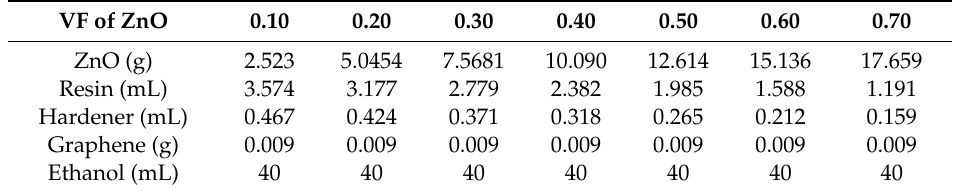
Figure 3. Fabrication procedure schematic: (1) measurement of ZnO nanoparticles, (2) addition of ZnO nanoparticles and ethanol to a beaker, (3) Sonication for 15 min, (4) measurement of Graphene nanoplatelets, (5) addition of Graphene nanoplatelets to the beaker, (6) Sonication for 15 min, (7) measurement of epoxy resin, (8) addition of epoxy resin to the beaker, (9) Sonication for 1 h, (10) measurement of epoxy hardener, (11) addition of epoxy hardener to the beaker, (12) Sonication for 30 min, (13) spin-coating of the sample on stainless-steel substrate, (14) curing of the sample on a hot plate at 75 °C for 10 h. Table 2. Quantities of ZnO, graphene, epoxy resin, and epoxy hardener based on the volume fraction (VF) of